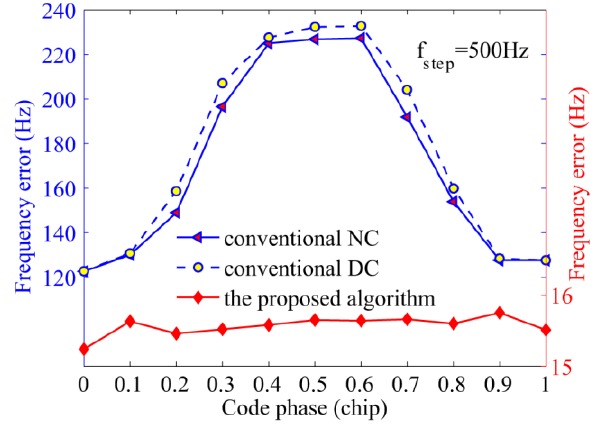
Figure 11. Average frequency errors of the NC, DC, and the proposed algorithms against the code phase.